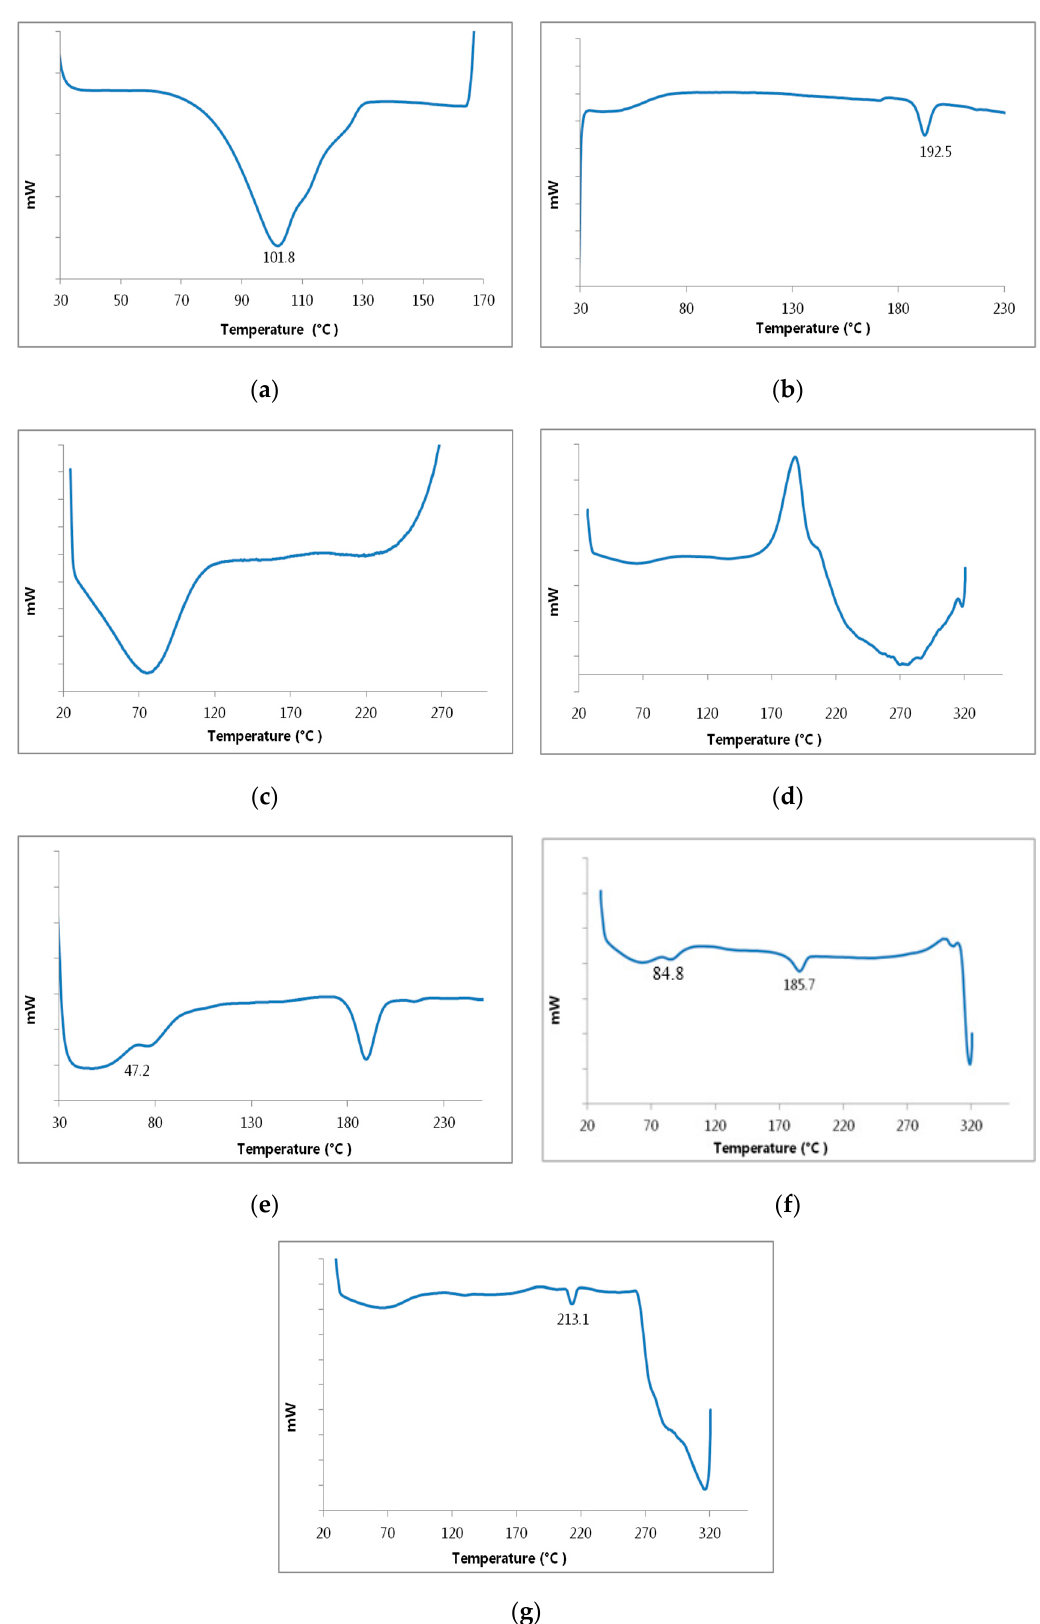
Figure 3. Differential scanning thermograms of: fenoprofen calcium dihydrate ( a ); TA- β -CD ( b ); HPMC ( c ); EC ( d ); drug- TA- β -CD complex 1:3 ( e ); HPMC/drug complex ( f ); EC/drug complex ( g ).